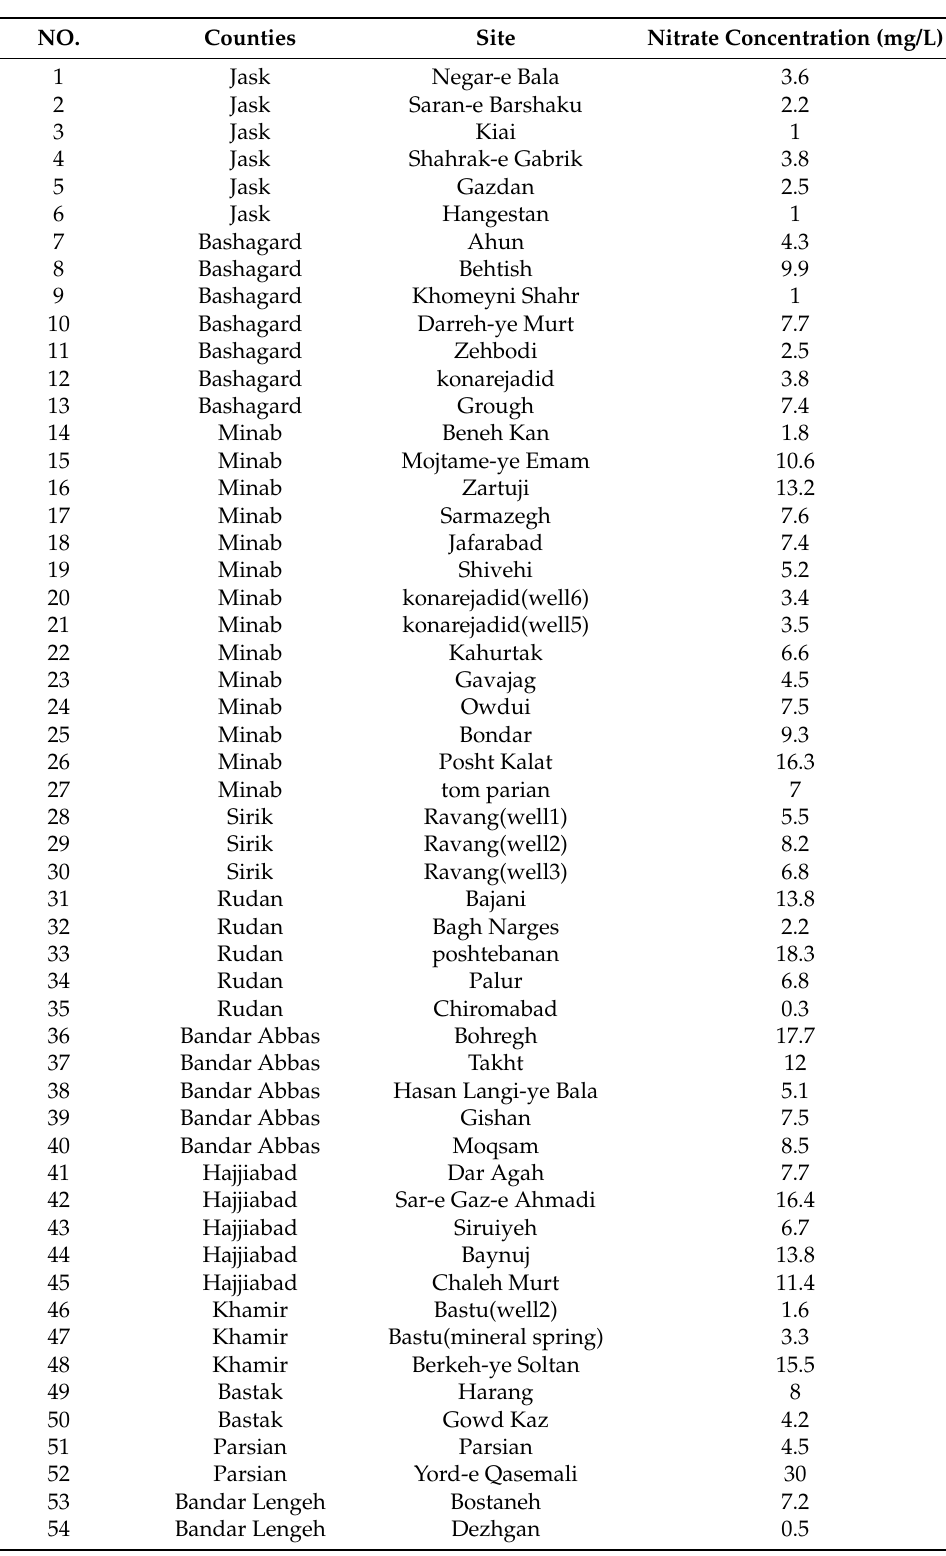
Table 2. Nitrate concentration in different sampling places in Hormozgan